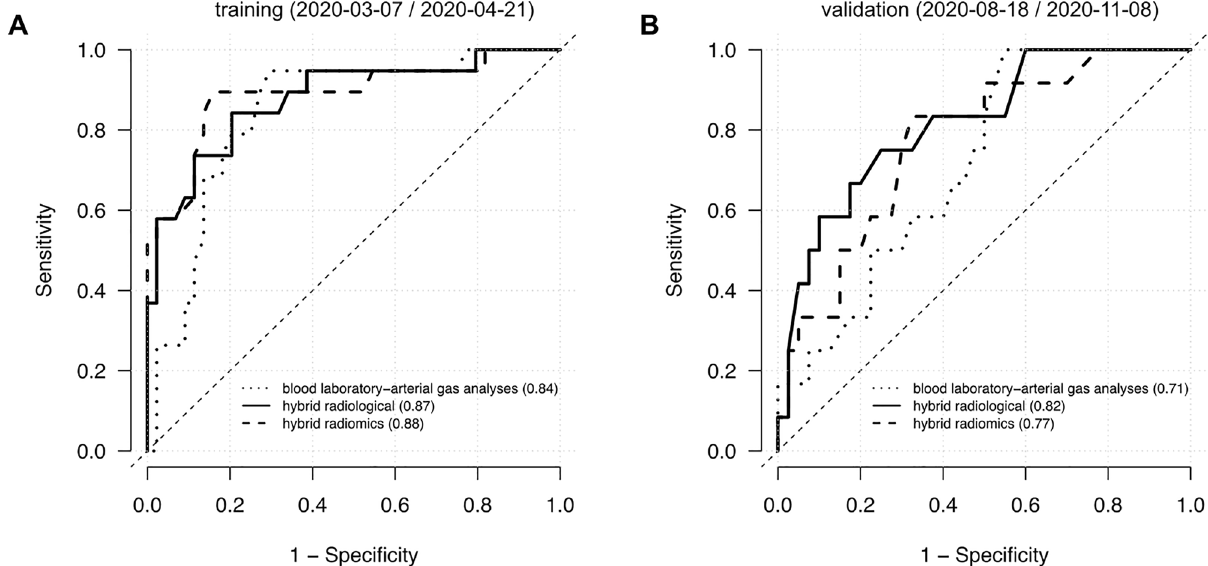
Figure 2. Performance of 3 models in predicting ICU admission. Receiving Operating Characteristic (ROC) curve analysis of the blood laboratory-arterial gas analyses features (dotted line), Hybrid radiological features (solid line) and Hybrid radiomics features (dashed line) in the training ( A ) and validation ( B ) sets. The values reported in parentheses refer to Area Under the ROC